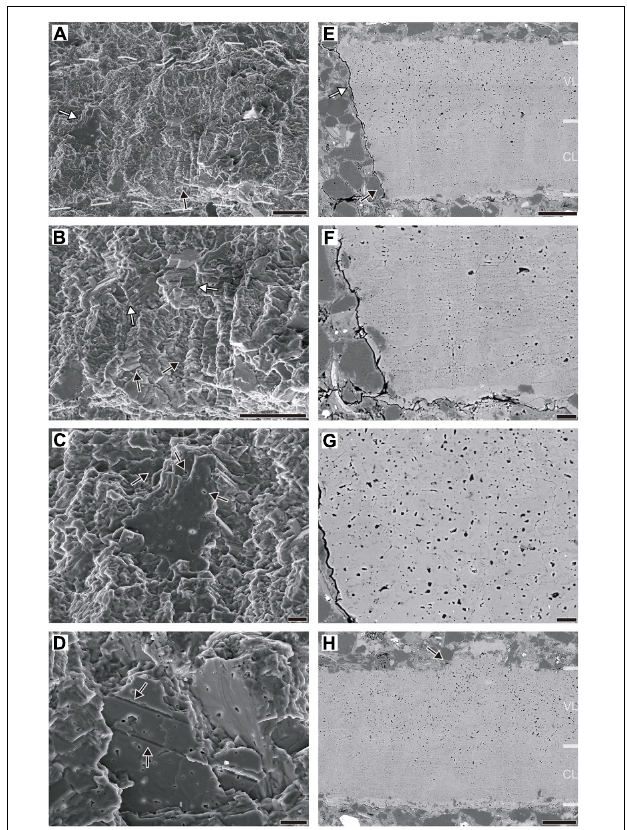
FIGURE 6 | Ultrastructural features of Aenigmaoolithus vesicularis oogen. et oosp. nov. (A–D) Secondary electron imaging (SNUVP 201703). (A) A fresh section. The boundaries of the eggshell are marked by dashed lines. The columnar structure is observed in the inner part (a black arrow). Occasionally, a section of the calcite plates composing the eggshell is exposed (a white arrow). (B) A detailed view of columnar structure. Note columnar structures (black arrows) and stacked calcite plates (white arrows). (C) A detailed view of an exposed calcite plate. Abundant vesicles are observed in the section and other parts of the eggshell (black arrows). (D) “Gully-like” structures exposed in calcite plates. The widths of “gully” are consistent with the diameter of larger vesicles. (E–H) Backscattered electron imaging (SNUVP 201704). (E) A polished section. Note the two layers: a compact layer (CL; a black arrow) and a vesicular layer (VL; a white arrow). (F) In CL, calcite contains very minute vesicles whereas large vesicles are uncommon. (G) In VL, larger vesicles are dominant but very minute vesicles are also present between the larger vesicles. (F) and (G) are in the same magnification. (H) Rarely, ornamentations are present at the outer surface of eggshell (a black arrow). Note the existence of larger vesicles in the ornamentation. Scale bars equal 50 µ m (A,B,E,H) ; 10 µ m (C,D,F,G)